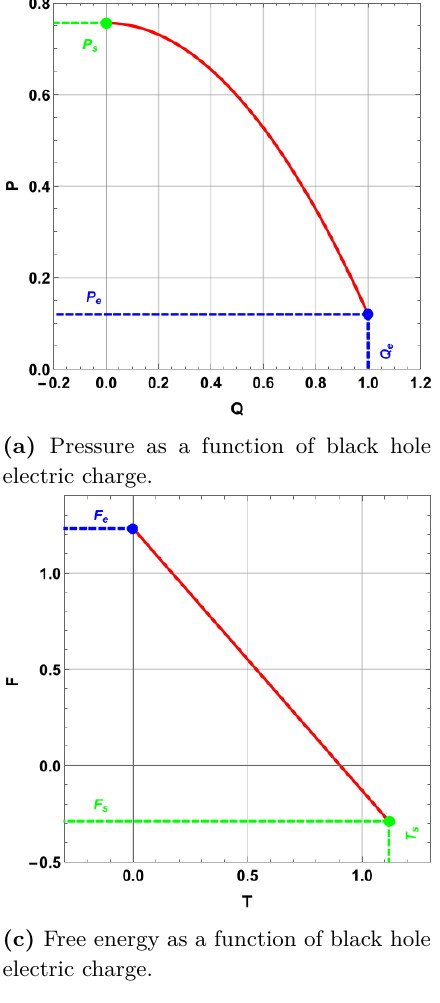
Figure 13. Evolution of different thermodynamical variables during an isentropic absorption of 500 particles with a fixed electric charge dQ = − 0 . 002 . The initial conditions are Q = 1 , l = 1 , M = 1 . 23 , r h = 0 . 65 and D = 4